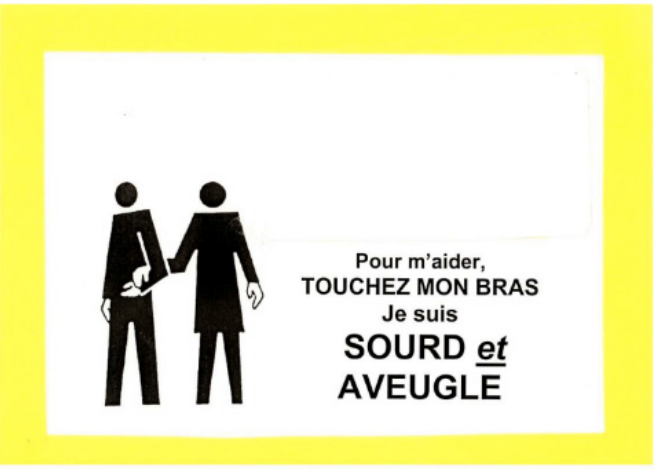
Figure 1. Sign inviting dialogue, in French, from [20] (p. 1).